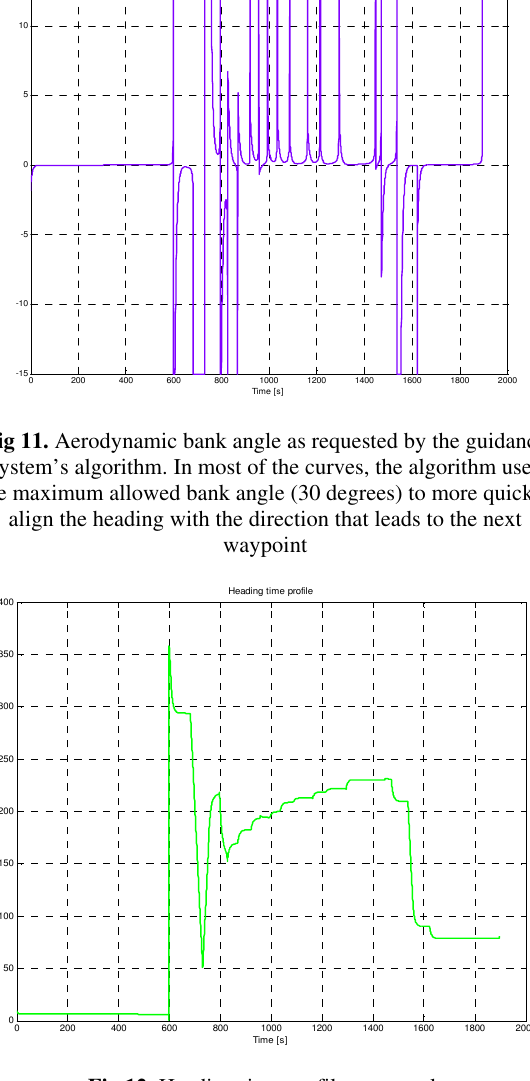
Fig 12. Heading time profile as a result of the aerodynamic bank